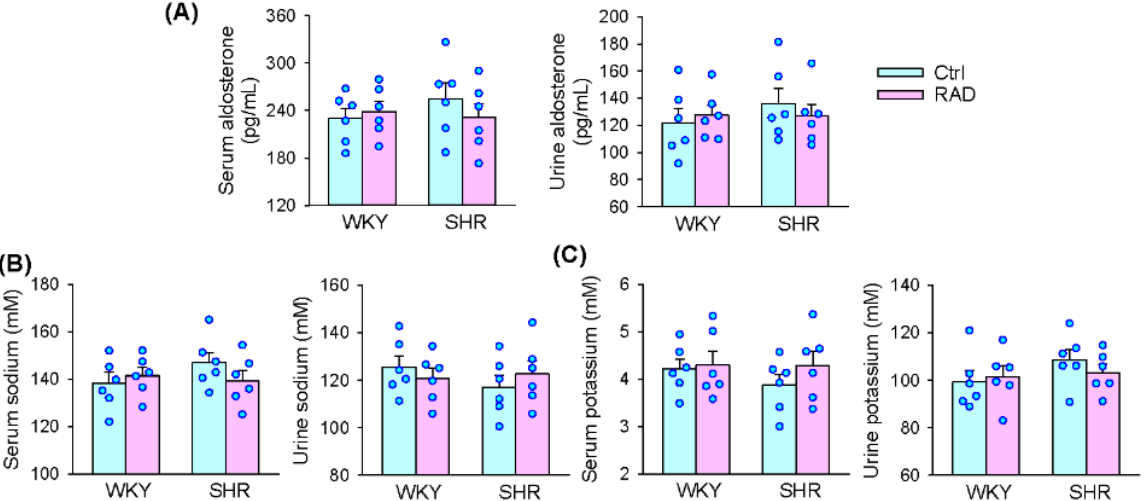
Figure 9. Effects of RAD on aldosterone, Na + and K + levels in serum and urine of WKY and SHR. ( A ) Serum and urine aldosterone levels. ( B ) Serum and urine Na + levels. ( C ) Serum and urine K + levels. Values are mean ± SE. Two-way ANOVA followed by Bonferroni’s post hoc analysis were used for comparisons. No significant difference among them. n = 6 for each group.